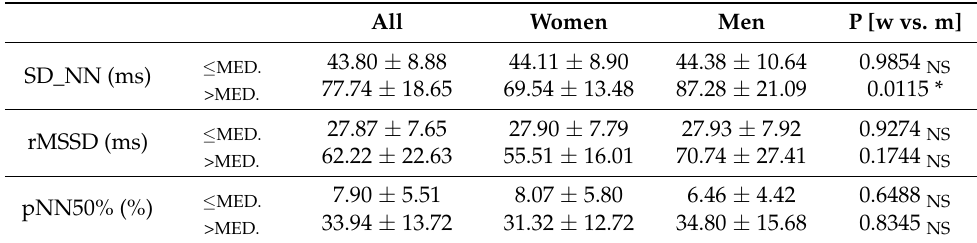
Table 4. Analysis of heart rate variability—HRV in the time domain for groups divided by the median.